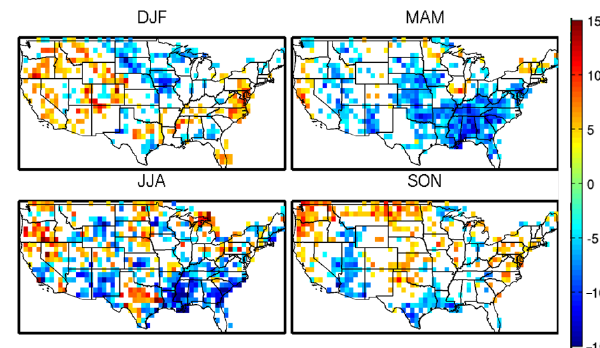
Figure 12. Differences between HSS of weeks 2–4 P mean forecasts during active MJO phases and the whole period at different loca- tions over the CONUS for DJF, MAM, JJA, and SON. The areas in white indicate the differences are not significant (at the 0.05 level).